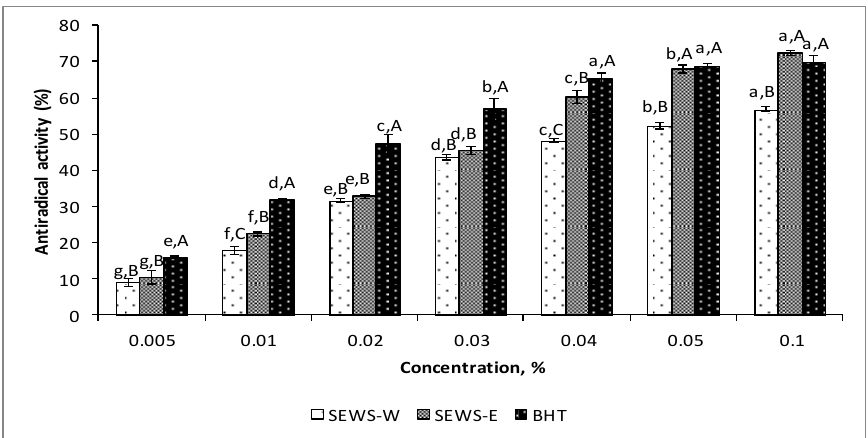
Figure 1. Scavenging effect of sunflower meal ethanol-wash solute dissolved in water (SEWS-W) and in ethanol (SEWS-E) on 2,2-diphenyl-1-picryl hydrazyl (DPPH) radical. a – g Means of one sample with different concentrations without a common letter differ significantly ( p < 0.05). A – C Means of the three samples with one and the same concentration without a common letter differ significantly ( p < 0.05). Standard deviations (SD) of the means varied from 0.34 to 3.09.